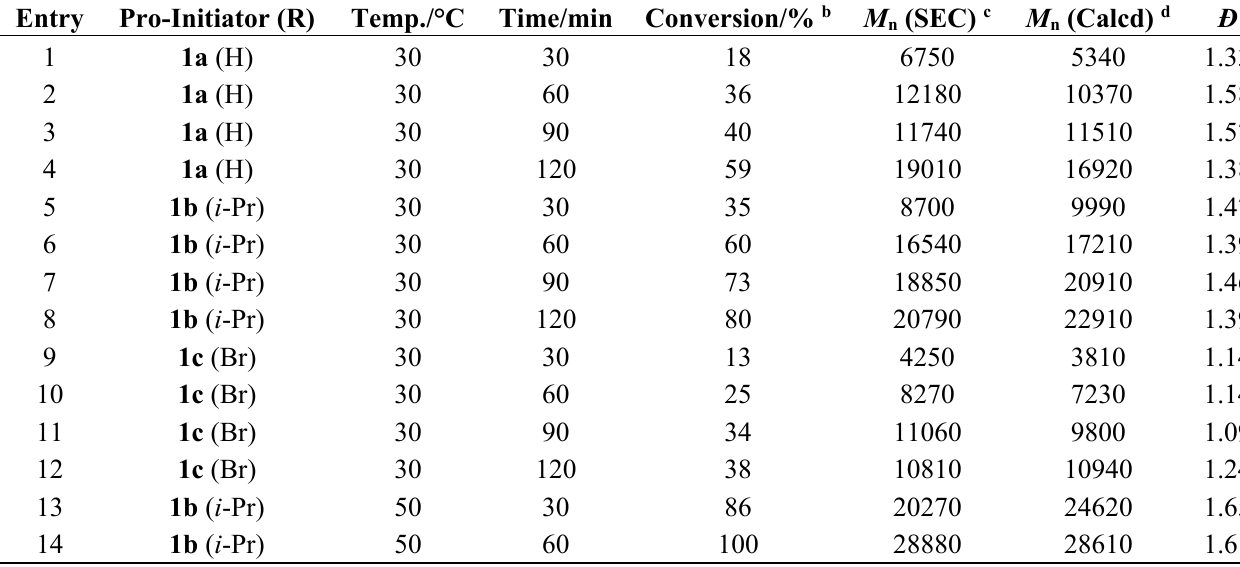
Table 3. Ring opening polymerization of ε-CL initiated by 1 /PhCH 2 OH catalyst systems a . Entry Pro-Initiator